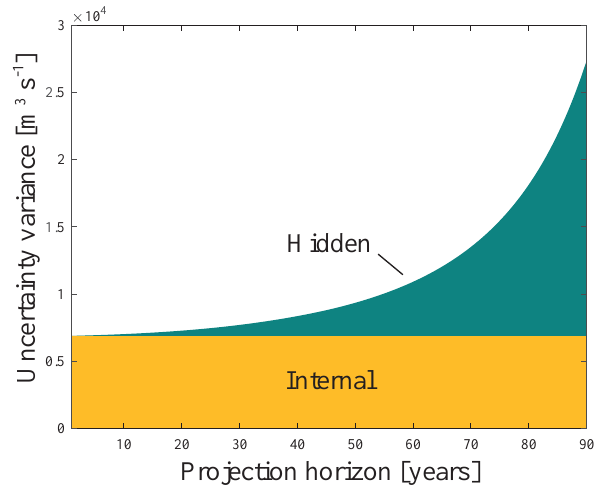
Figure 1. Absolute values of hidden uncertainty and internal vari- ability over the projection horizon for the CCLM projection at